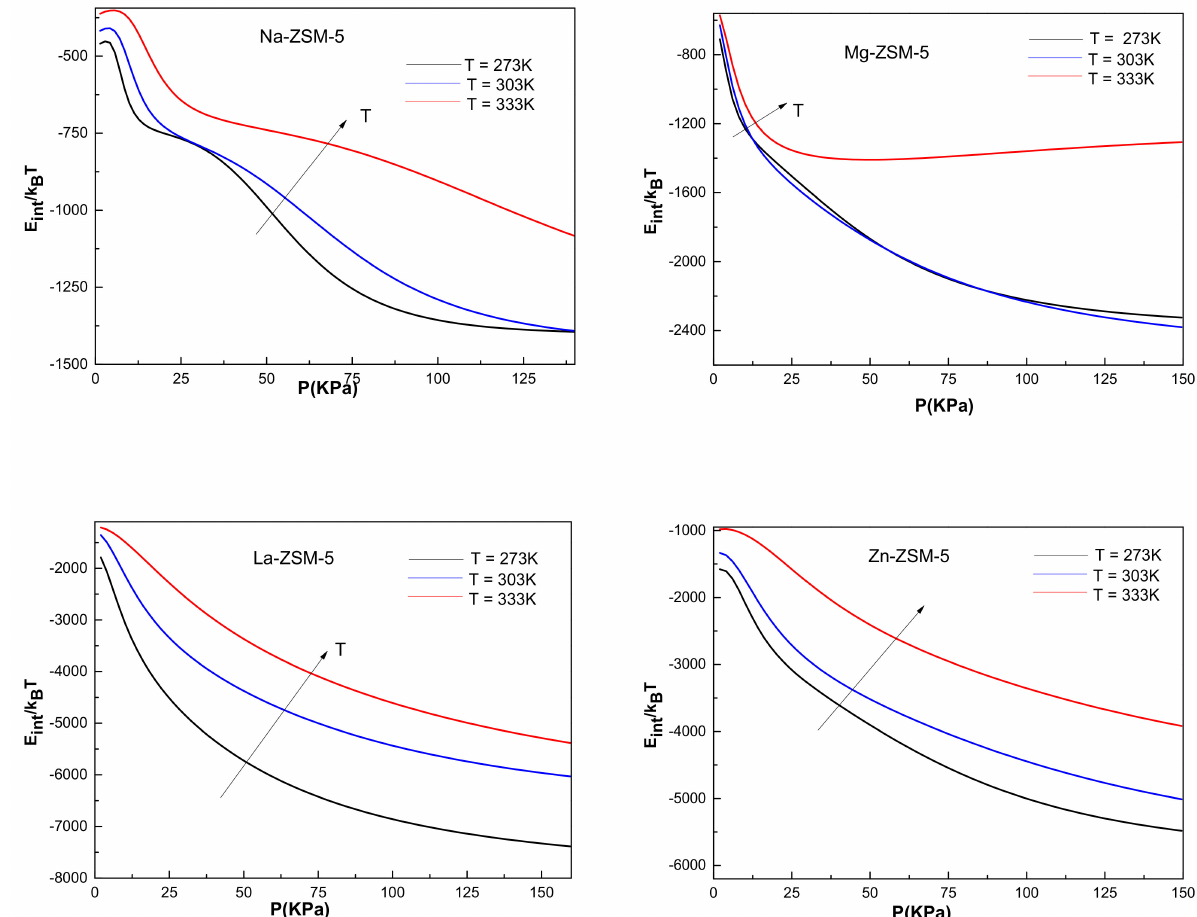
Figure 12. Evolution of internal energy versus pressure for the four tested systems at three